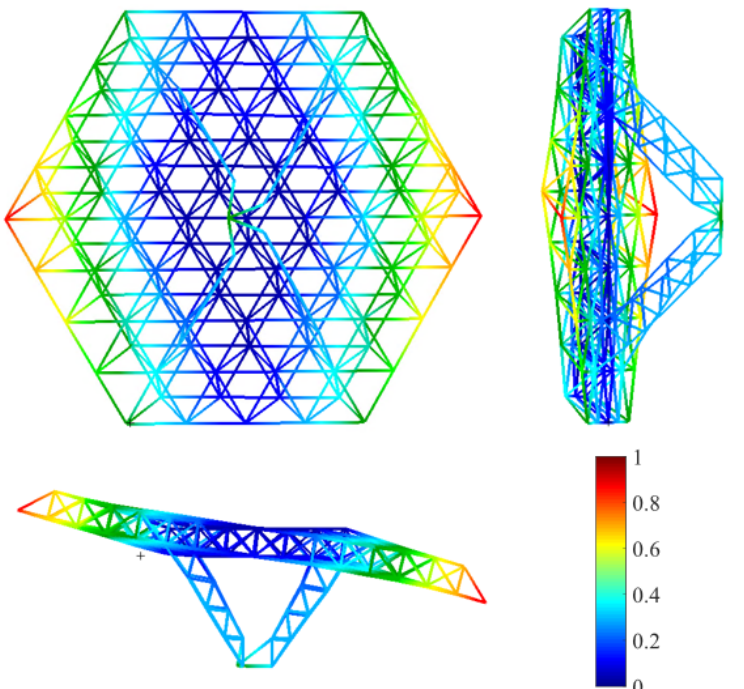
Figure 8. First resonance frequency (2.8 Hz) mode shape of the antenna frame. The color bar indicates the normalized net displacements with respect to the maximum value obtained.